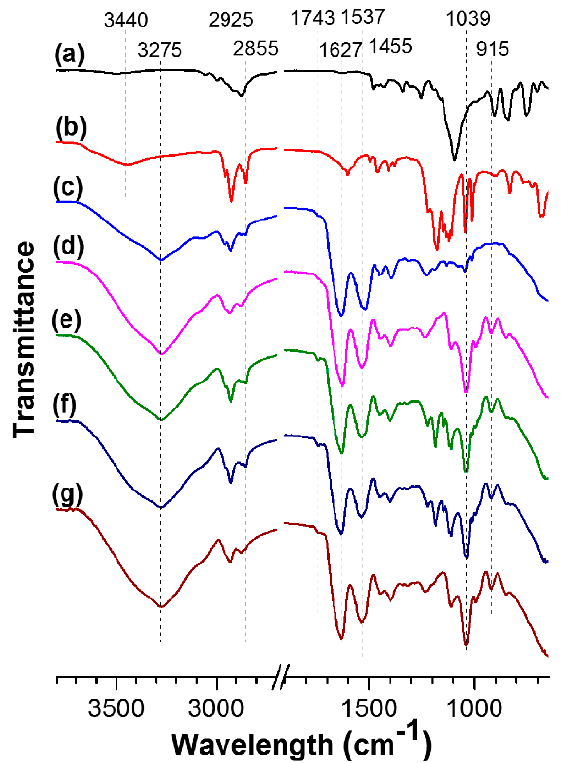
Figure 3. FTIR spectra of PEGE ( a ), SDBS ( b ), SPI powder ( c ), and films of SPI ( d ), SPI/SDBS ( e ), SPI/SDBS/PEGE4% ( f ), and SPI/PEGE4% ( g ).